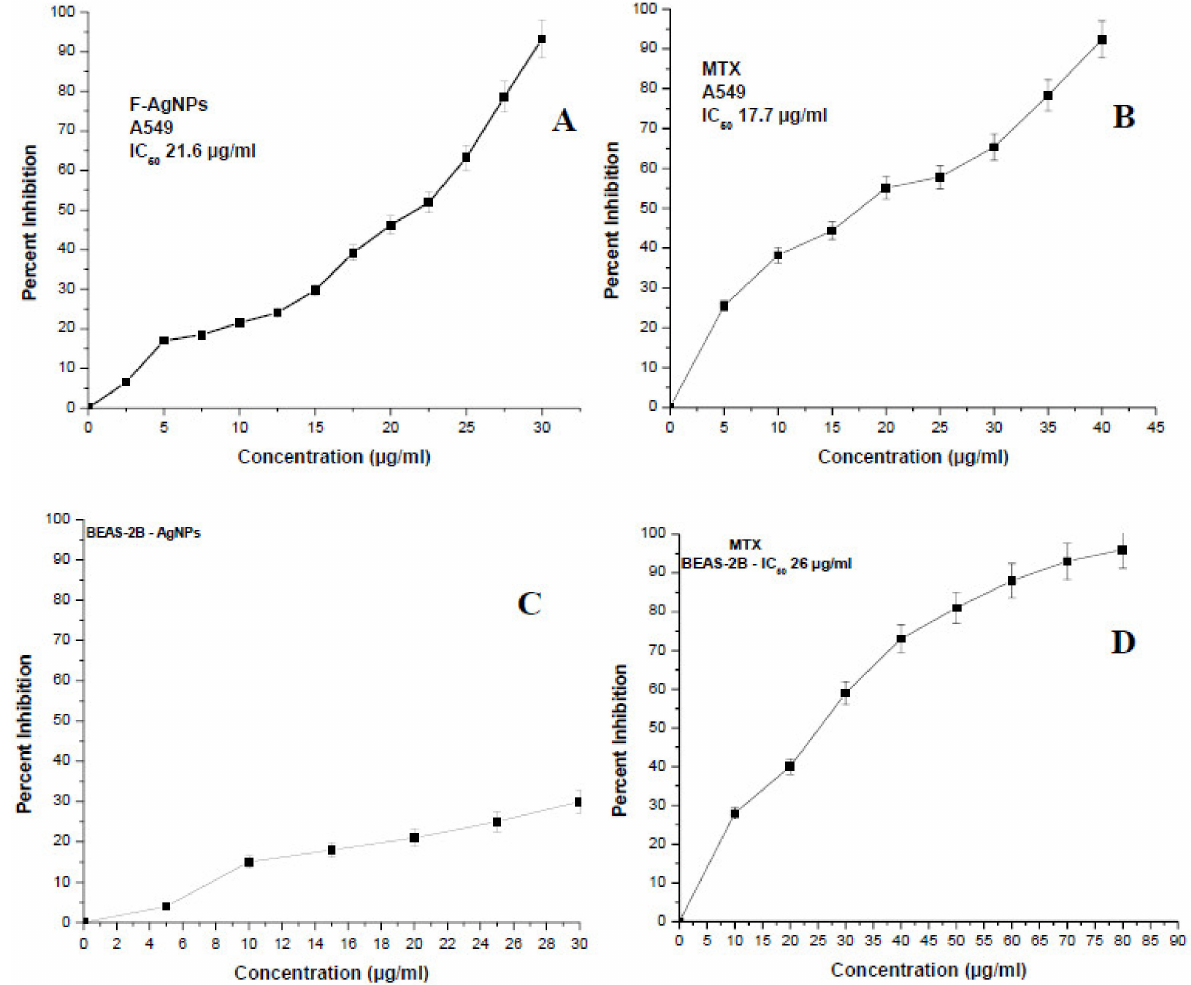
Figure 4. The dose-dependent cytotoxicities of ( A ) F-AgNPs treated A549 cells, ( B ) methotrexate (MTX) treated A549 cells, ( C ) F-AgNPs treated BEAS-2B cells, and ( D ) methotrexate (MTX) treated BEAS-2B cells, were evaluated after 24 h of incubation at 37 ◦ C via MTT assay. Every datum shown is the mean ± SD of three